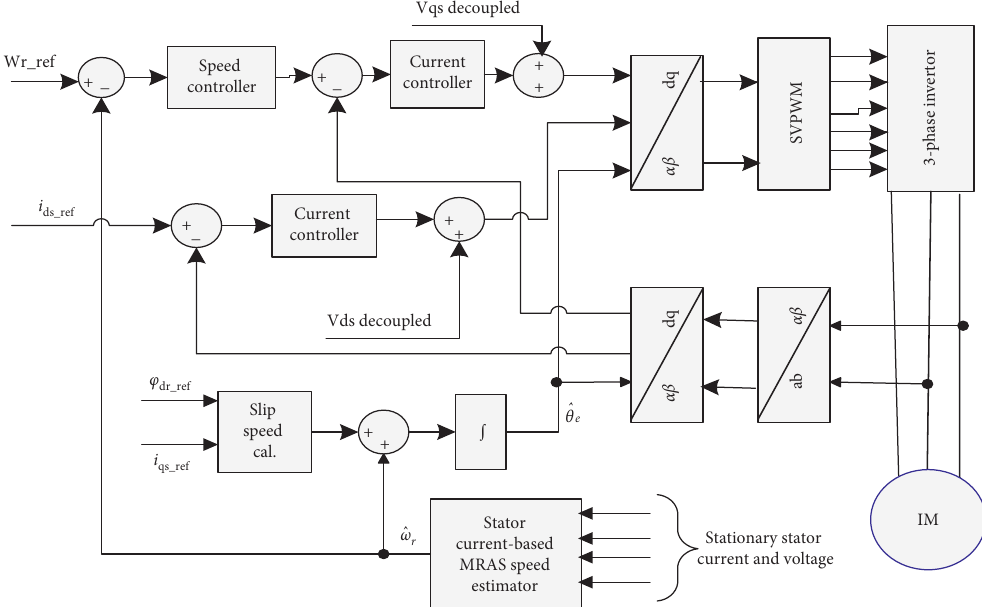
Figure 1: General block diagram of MRAS-based sensorless speed control of the induction